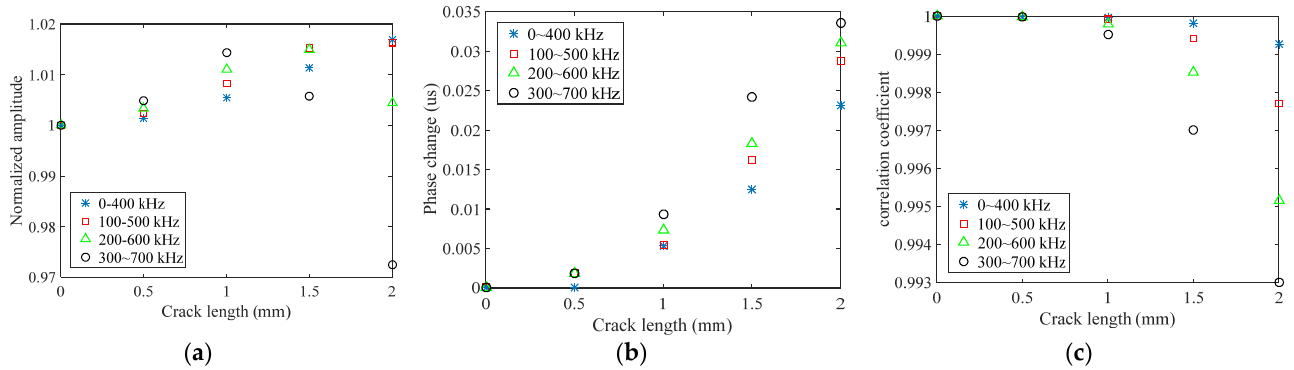
Figure 6. Crack length versus damage features of L-Chirp signals: ( a ) normalized amplitude; ( b ) phase change; ( c ) correlation coefficient.